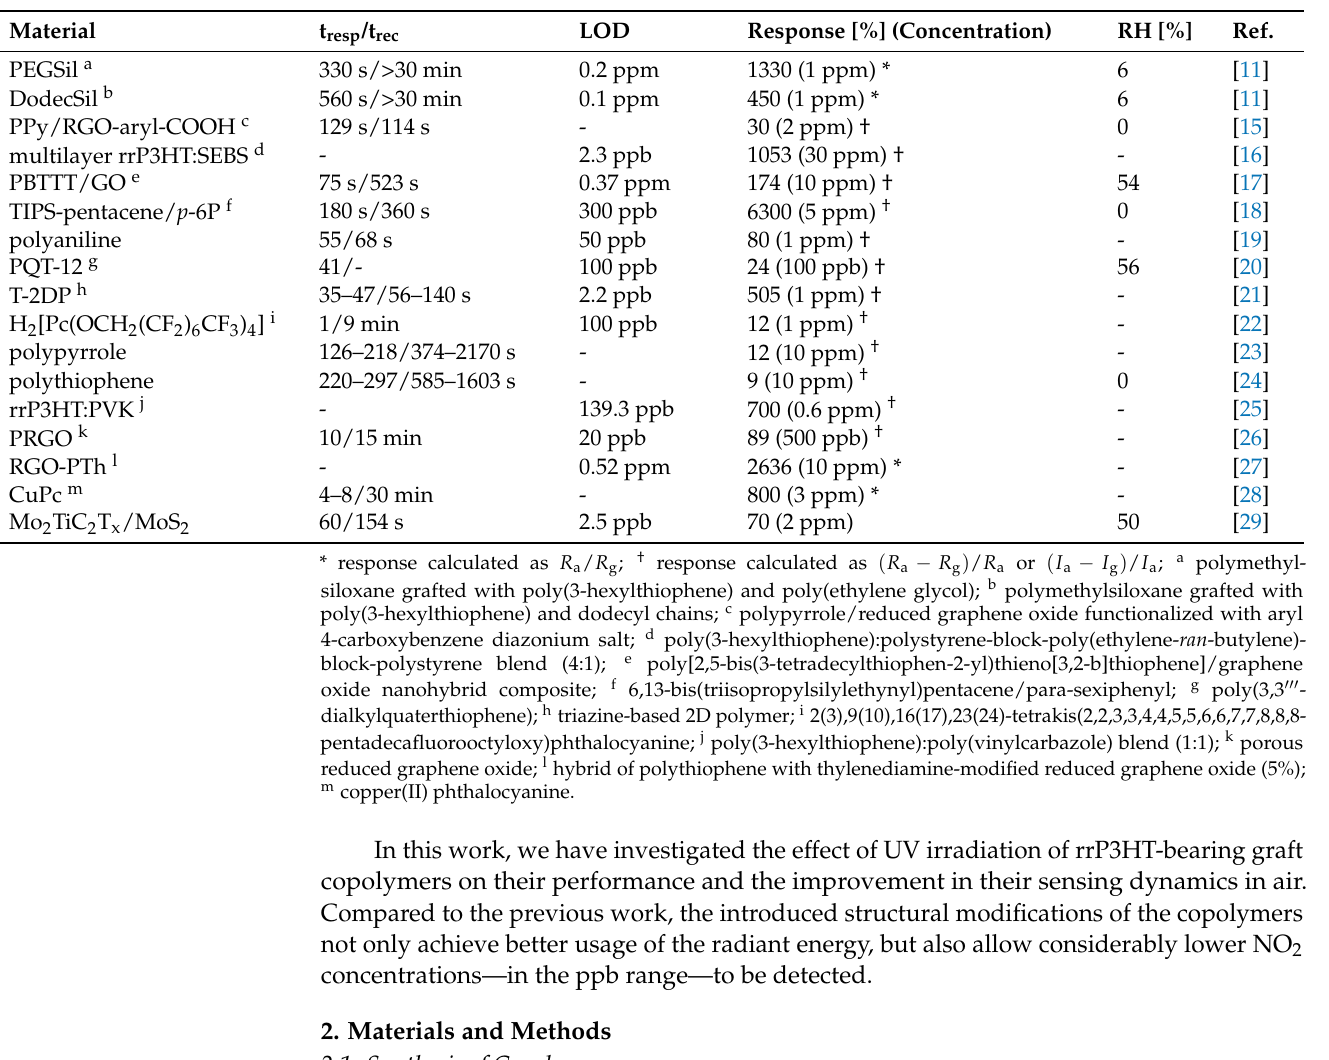
Table 1. Recently reported room temperature NO 2